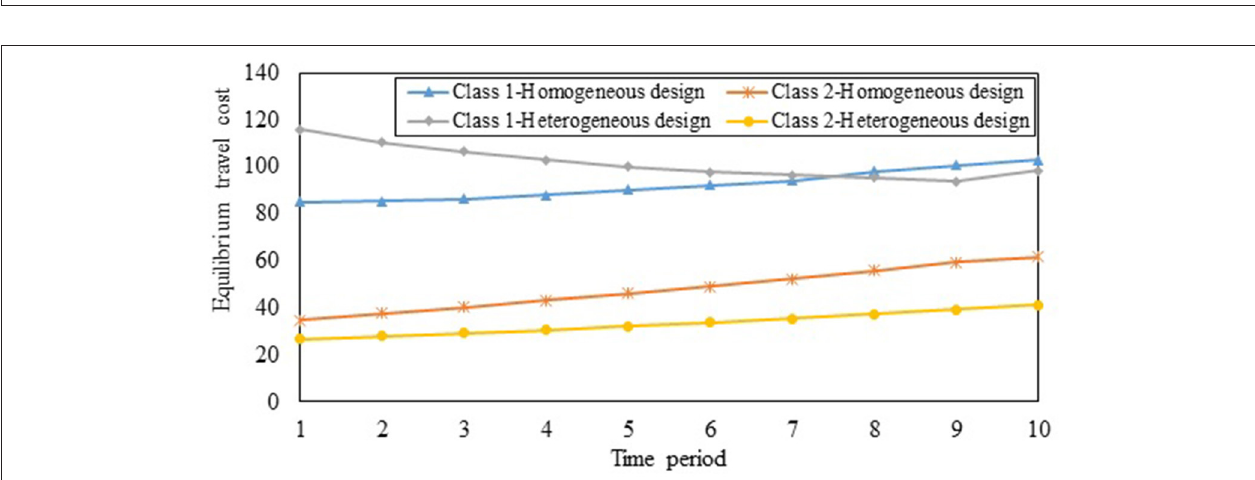
FIGURE 10 | Equilibrium travel costs under system optimal multi-period TCS design.